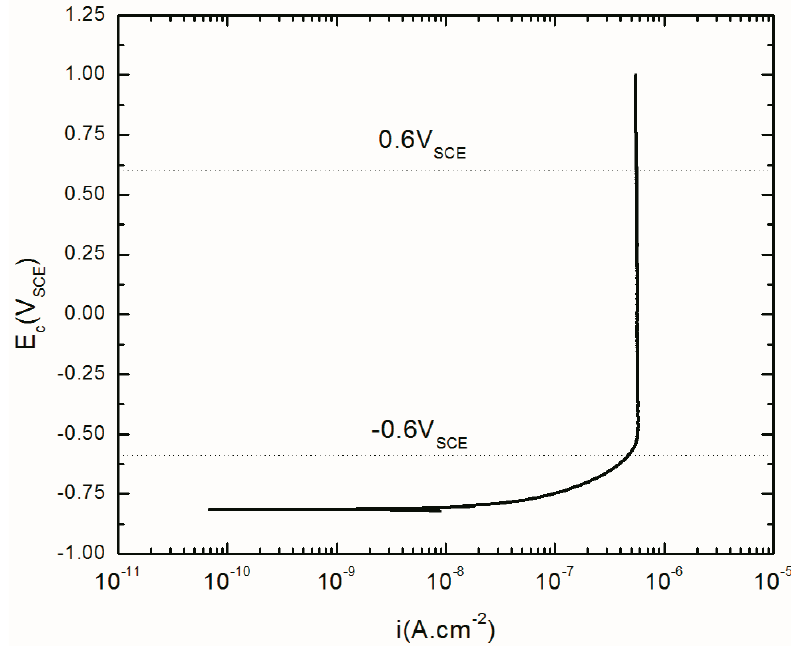
Figure 1. Polarization curve of AA2098 – T851 alloy in 0.1M NaHCO 3 /1 atm of CO 2 at 25 °C.